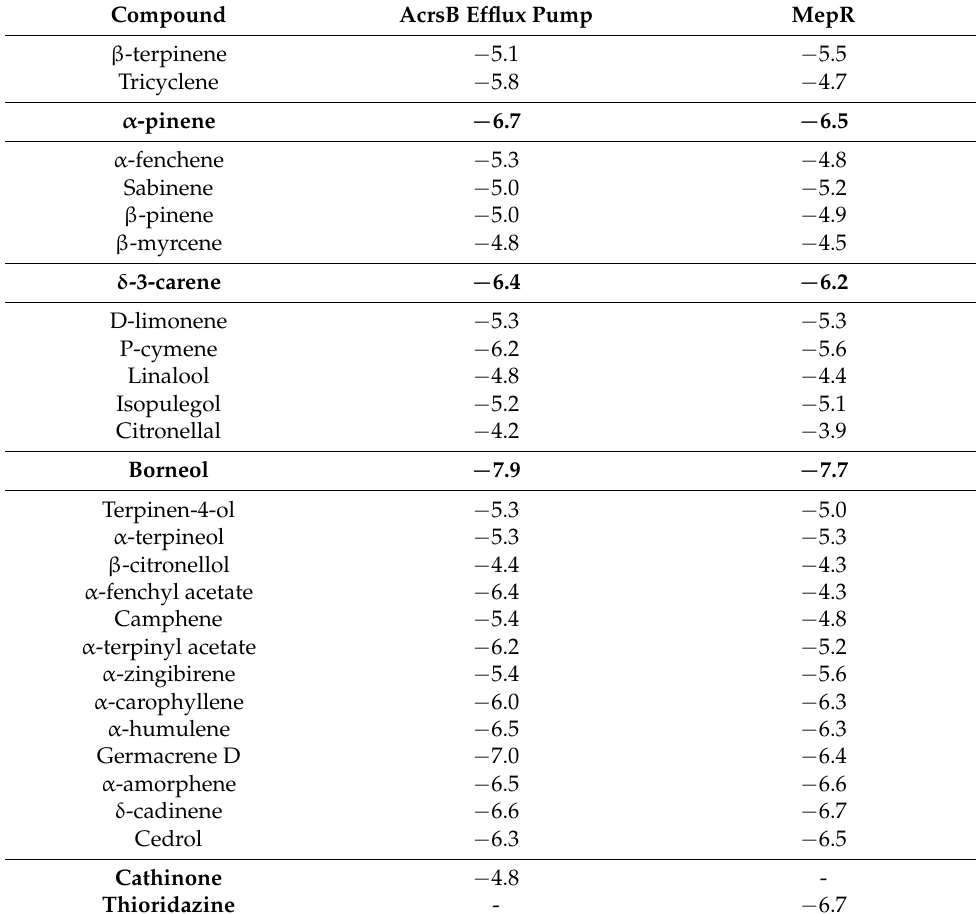
Table 6. Molecular docking results for complexes between compounds of (CSEO) and efflux pump targets of S. aureus and S. enterica Typhimurium by using Autodock Vina